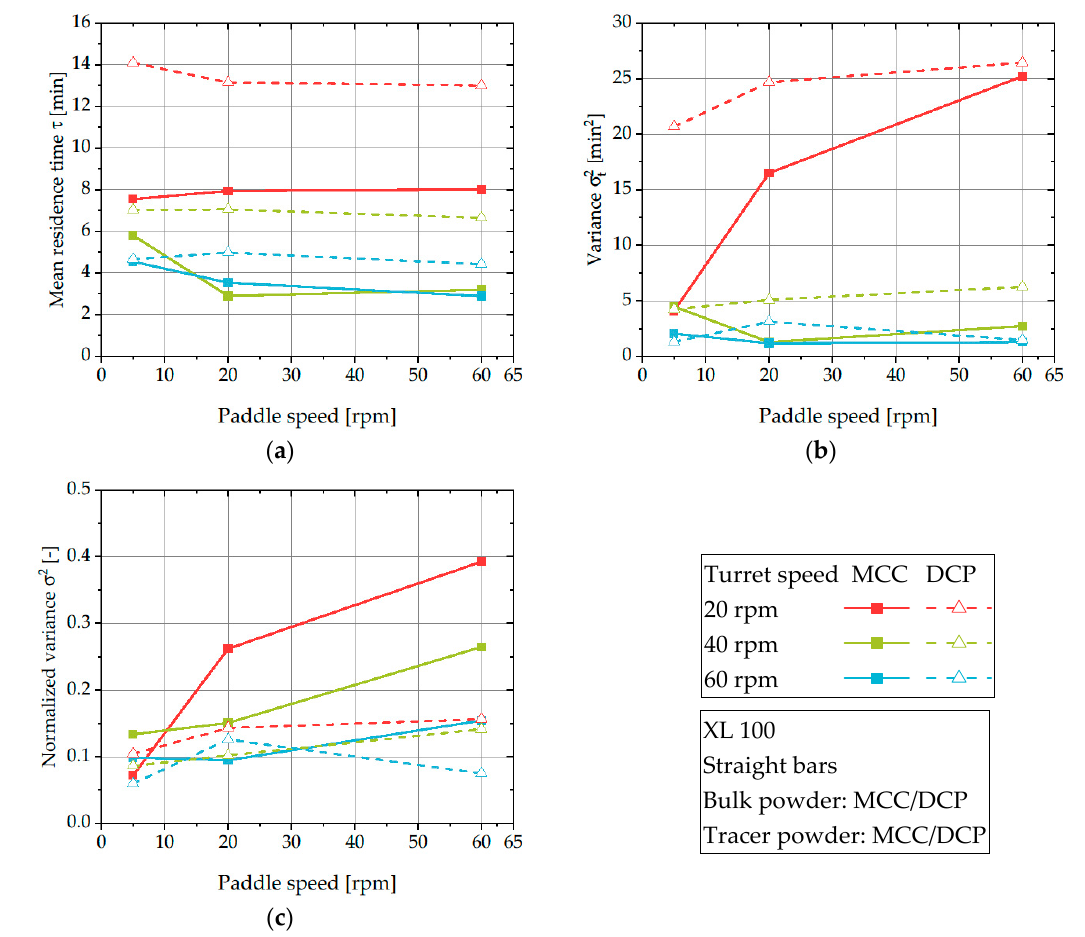
Figure 7. Influence of turret and paddle speed on mean residence time ( a ), variance ( b ), and normalized variance ( c ) of DCP and MCC using the XL 100.